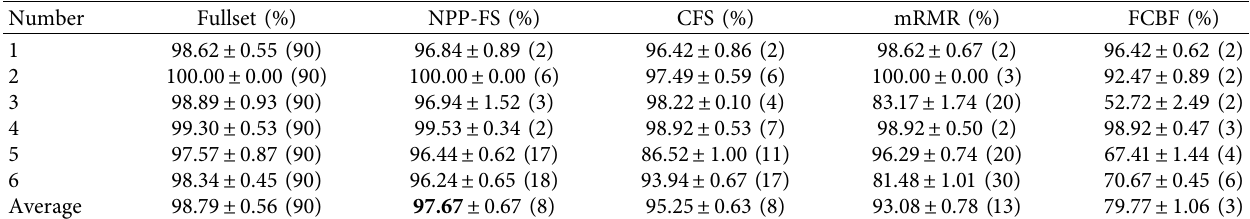
Figure 8: The reciprocal of the subset dimension changes with the parameter value. (a)–(f) represent experiments 1 to 6. Table 4: Comparison of feature selection algorithms under LR classifier.